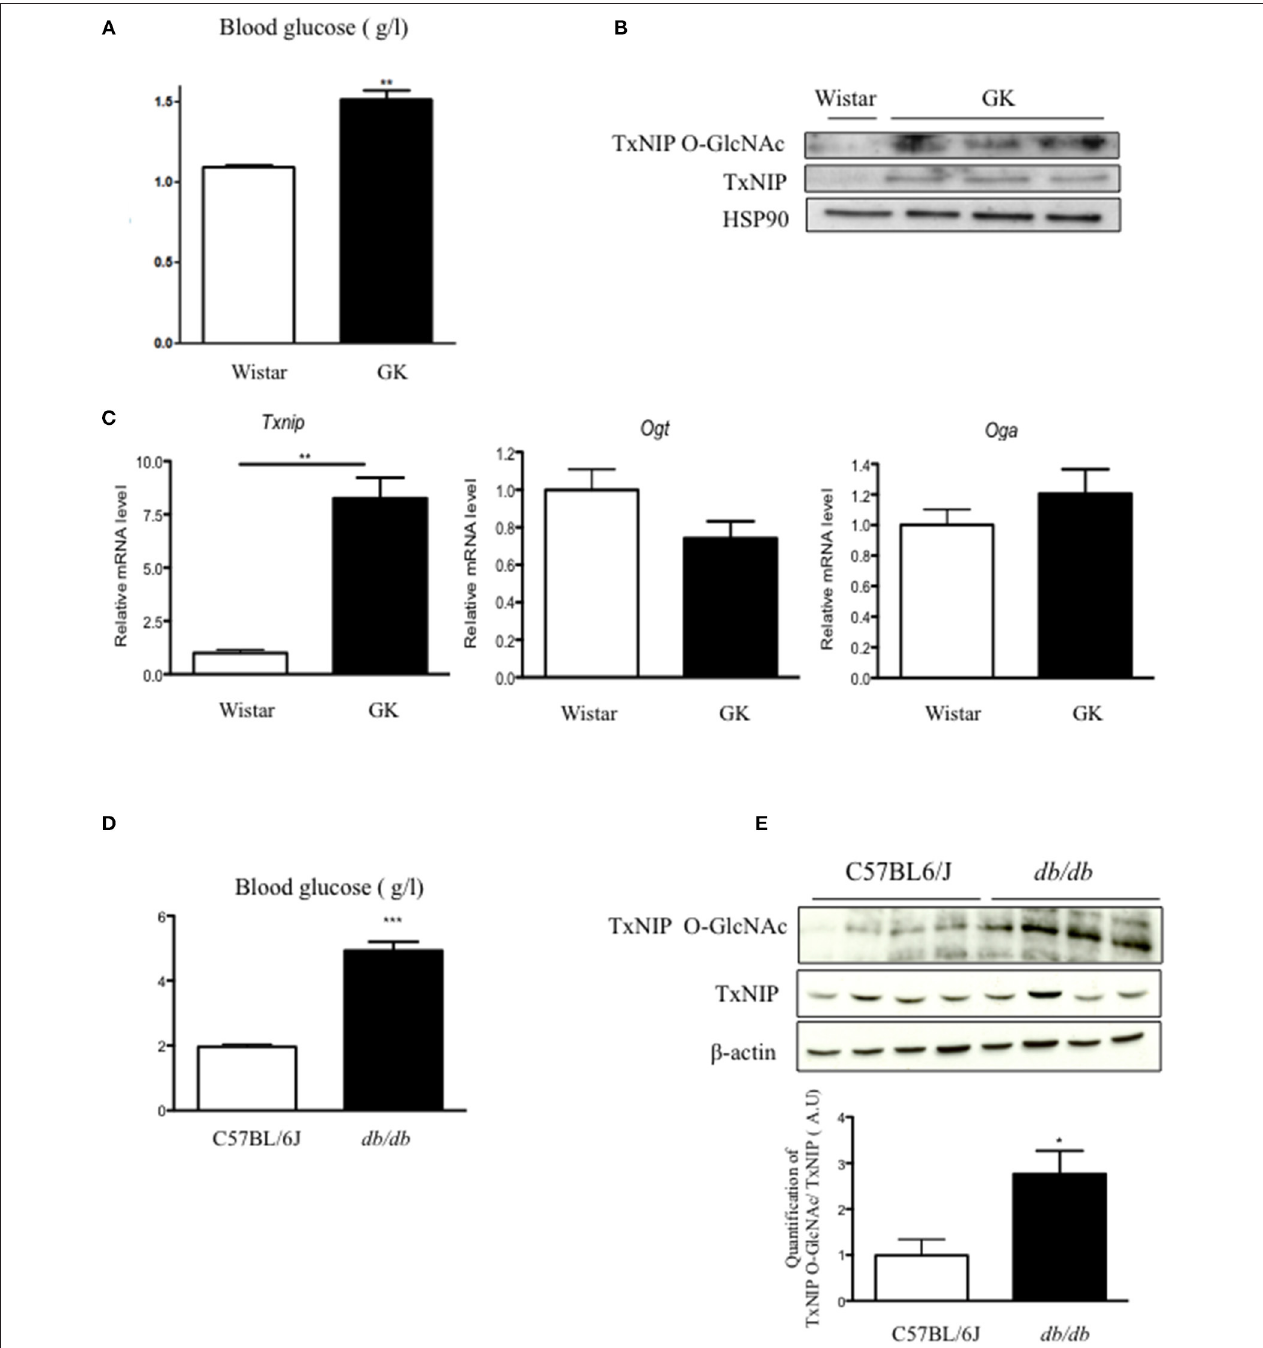
FIGURE 1 | O-GlcNAcylation of TxNIP is increased in rodent models of diabetes. (A) Blood glucose concentrations were measured in fed condition in wister and GK rats. (B) Txnip , Ogt, and Oga mRNA levels in islets of wistar and GK rats. Significance is based on Mann-Whitney test. ** p < 0.01. n = 3–5. (C) TxNIP O-GlcNAcylation level evaluated by WGA binding experiments. Islet lysate proteins were immunoblotted with TxNIP and HSP90 was used as a loading control. (D) Blood glucose concentrations were measured in C57/B6J and db/db mice. Significance is based on Mann-Whitney test. *** p < 0.001 (E) TxNIP O-GlcNAcylation was evaluated by WGA binding experiments. Whole pancreas proteins were immunoblotted with a TxNIP antibody and β -actin was used as a loading control. Quantification of the ratio of O-GlcNAcylated TxNIP corrected to total TxNIP protein is shown. Significance is based on student’s T -test followed by Welch correction post-hoc test. * p < 0.05. n =